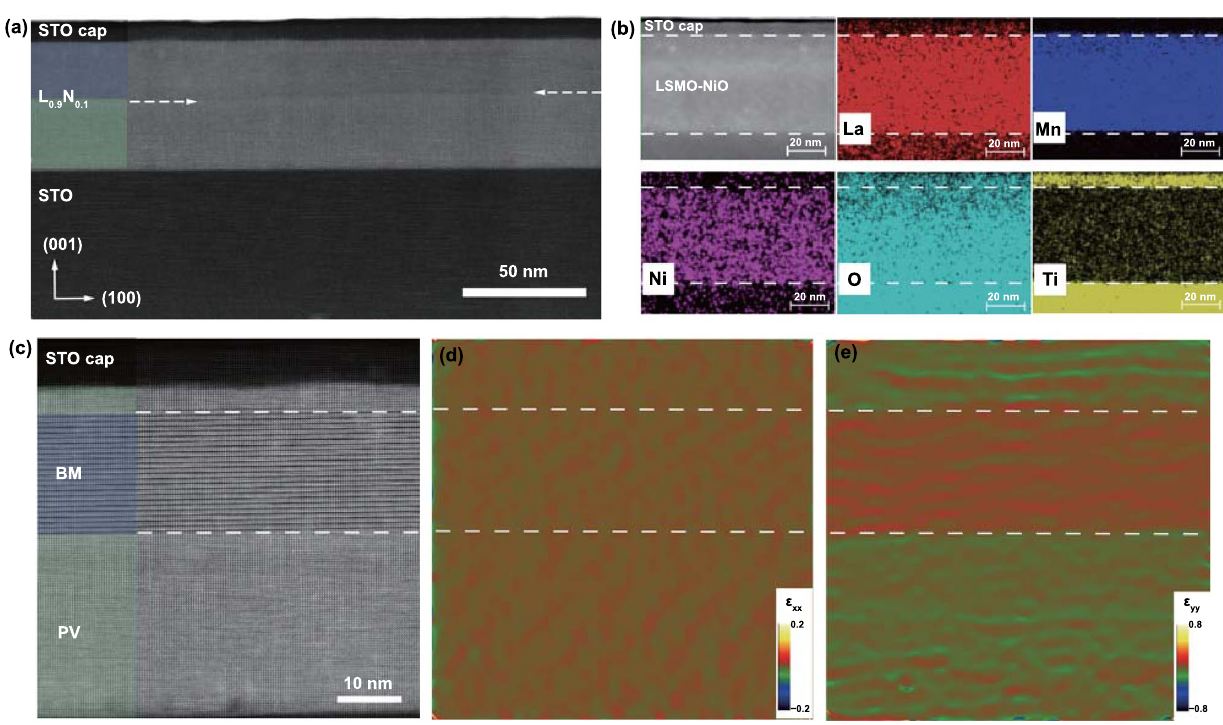
Fig. 2 a Cross-sectional HAADF-STEM image and b element-specific EDS maps of a vacuum-annealed STO/L 0.9 N 0.1 film illustrating the over- all thin-film structure and uniform distribution Ni and the constituent elements of the film. c High-resolution STEM image showing a three-layer structure formed in the vacuum-annealed STO/L 0.9 N 0.1 film consisting of a 4-nm-thick PV phase as the top layer, a 20-nm-thick BM phase as the middle layer and a 28-nm-thick PV phase as the bottom layer. The corresponding strain maps along the d ε xx and e ε yy directions. The phase boundaries between PV and BM structures are marked with white dotted lines. The entire bottom PV region is used as the reference for the GPA